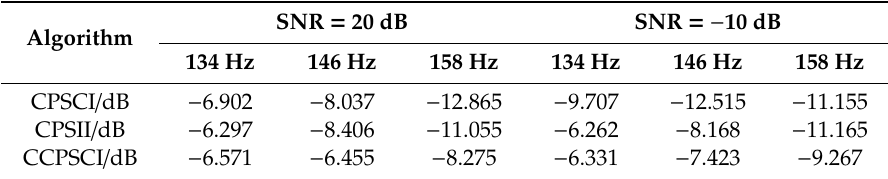
Table 2. Averages of discrete spectra in